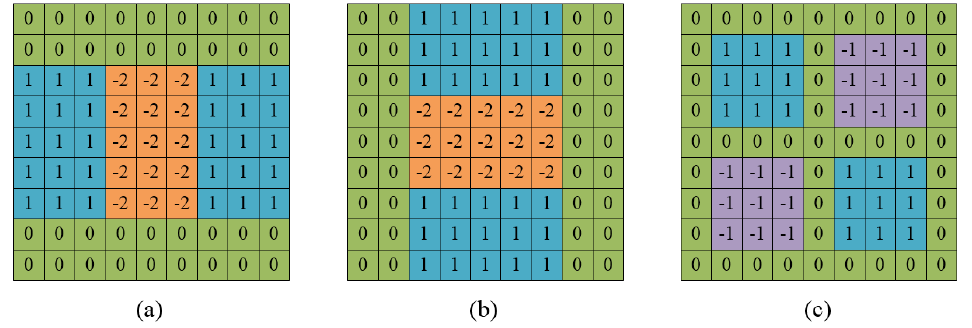
Figure 9. Three filters used for interest point detection in horizontal, vertical, and diagonal directions. ( a ) The filter used in the horizontal direction. ( b ) The filter used in the vertical direction. ( c ) The filter used in the diagonal direction. ( a – c ) are performed on each pixel of a CTU, and the corresponding filtering responses are D xx , D yy , and D xy ,